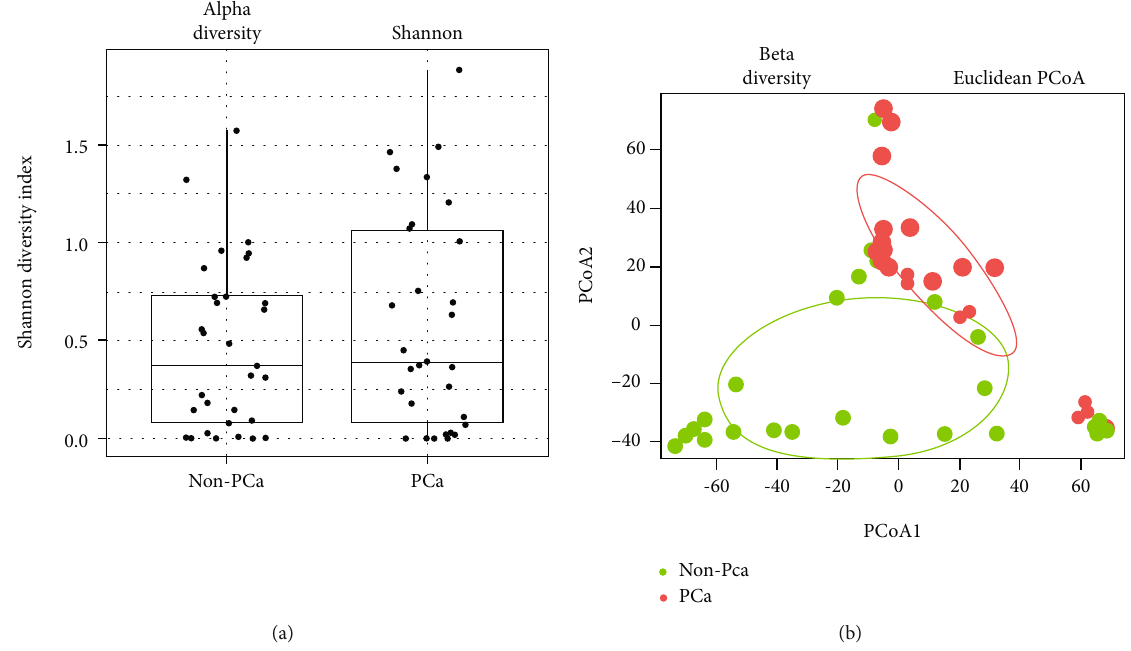
Figure 1: Alpha and beta diversities in prostate cancer patients and healthy men. (a) Alpha diversity and (b) beta diversity of plasma